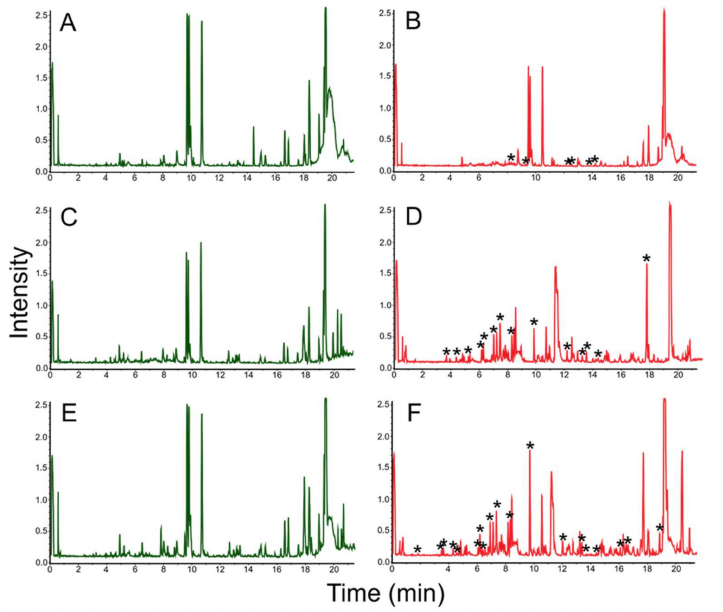
Figure 11. Chromatograms of natural products extracted from MM with birch sawdust added (left column, control parameters) and MM (left column, experimental parameters) where Microbacterium sp. LPB2019K198-2 was cultivated: ( A ) MM media without sawdust (control); ( B ) Microbacterium sp. LPB2019K198-2 cultivated on MM media without sawdust (control); ( C ) MM media with a relatively low content of birch sawdust (control); ( D ) Microbacterium sp. LPB2019K198-2 cultivated on MM media with a relatively low content birch sawdust; ( E ) MM media with a relatively high content of birch sawdust (control); ( F ) Microbacterium sp. LPB2019K198-2 cultivated on MM media with a relatively high content of birch sawdust. *-asterisks indicate the differences (new peaks) between MS-spectrums of control and